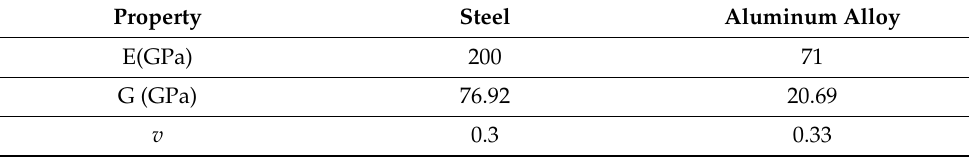
Table A8. Steel and T 6061-T6 aluminum alloy mechanical properties